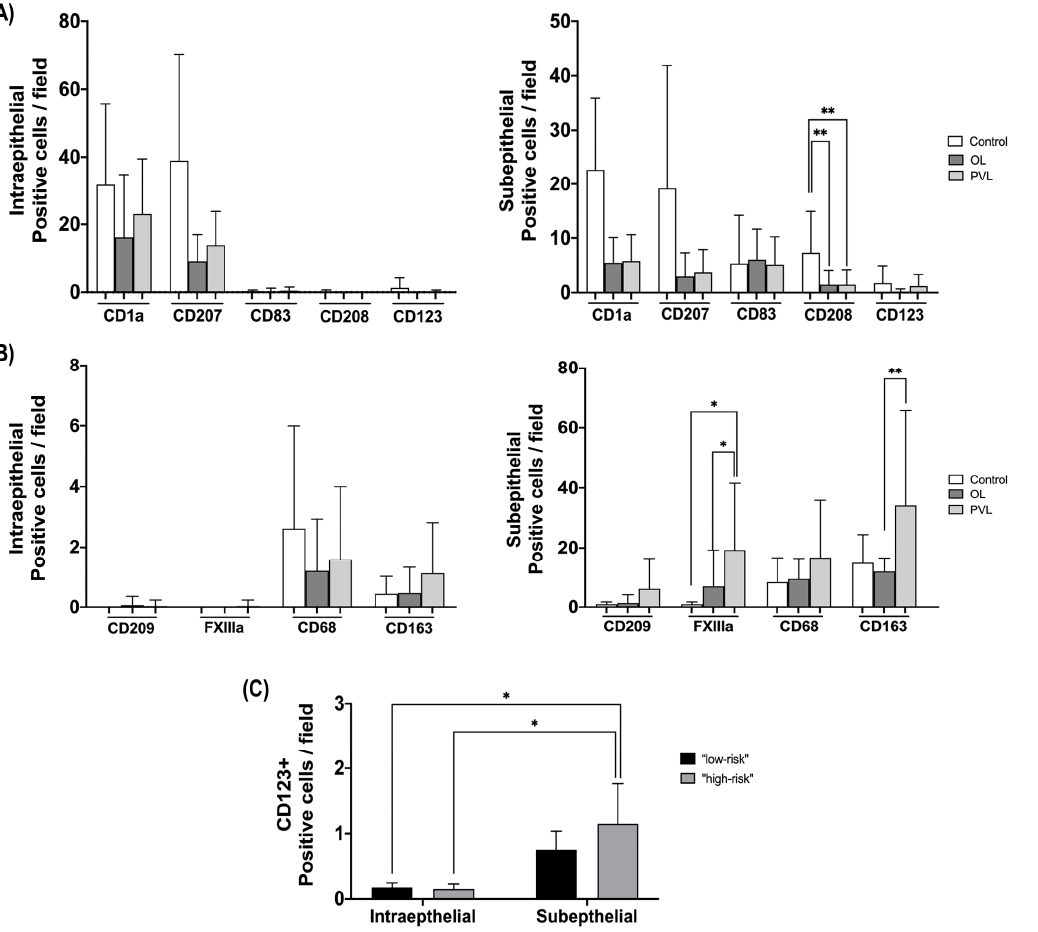
Figure 1. Results of immunostaining quantification and statistical differences for DC and macrophage markers. ( A ) CD1a+, CD207+, CD83+, CD208+ and CD123+ cells with dendritic morphology